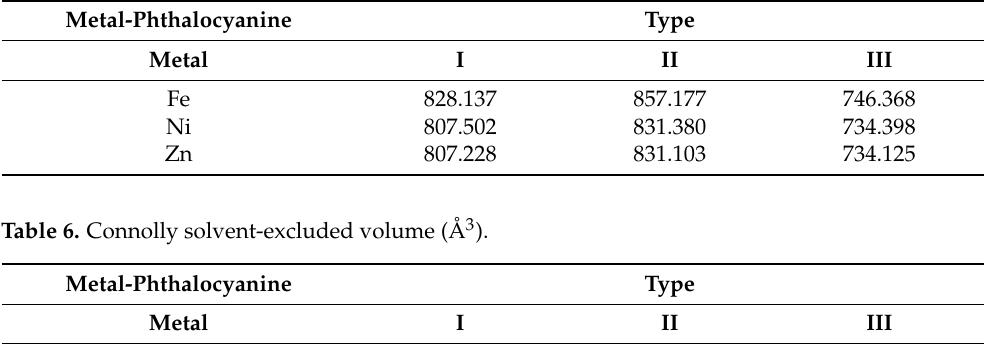
Table 5. Connolly accessible area values (Å 2 ).